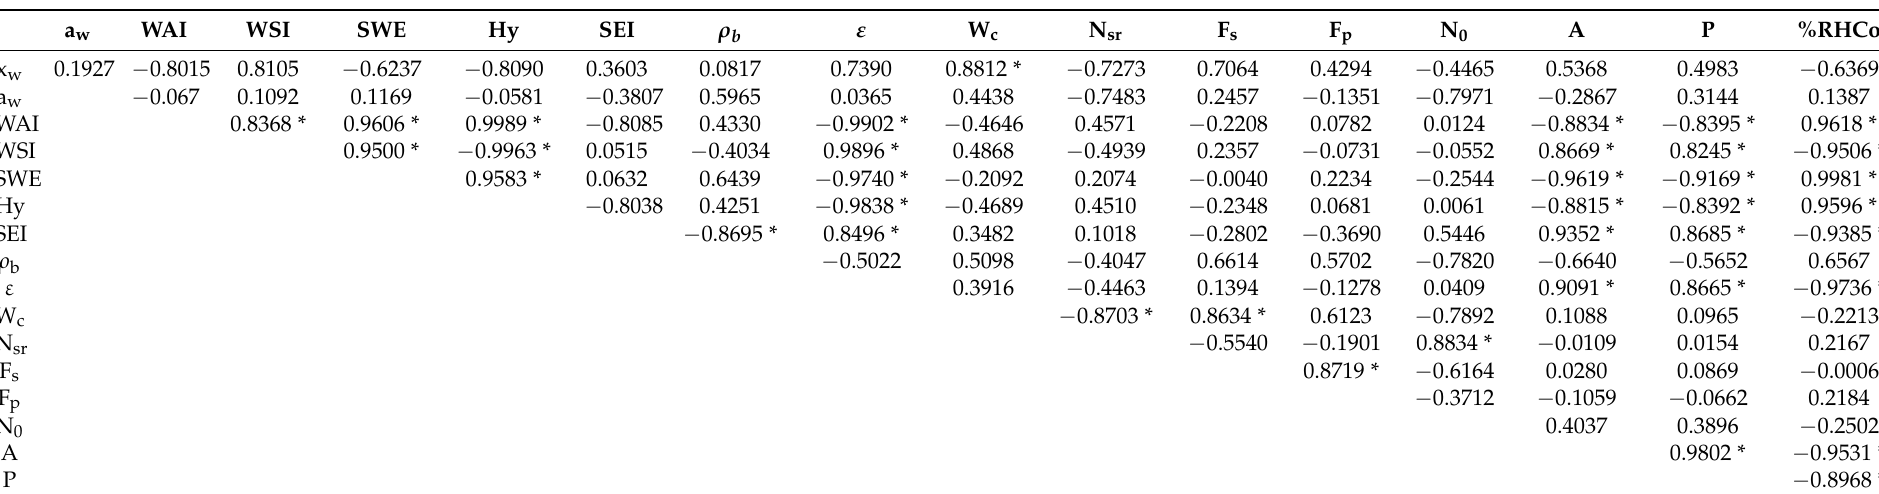
Table 4. Pearson correlation coefficients among studied parameters of extruded product and RHCo